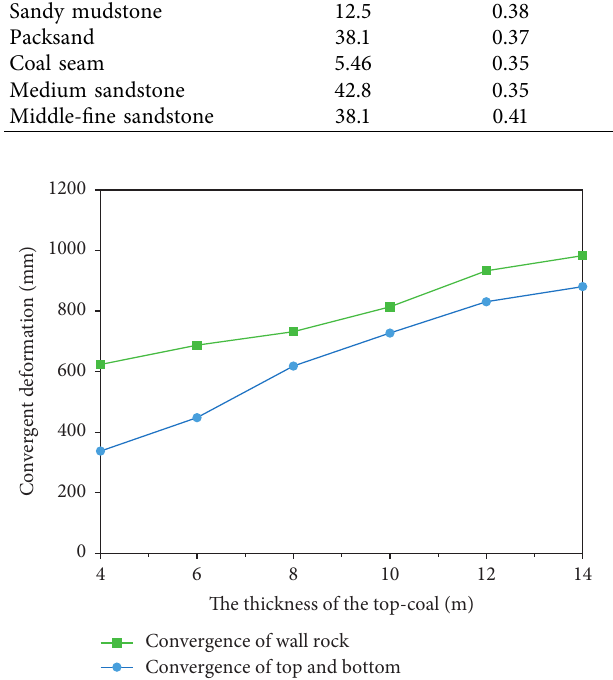
Figure 7: Convergence of surrounding rock with different top coal